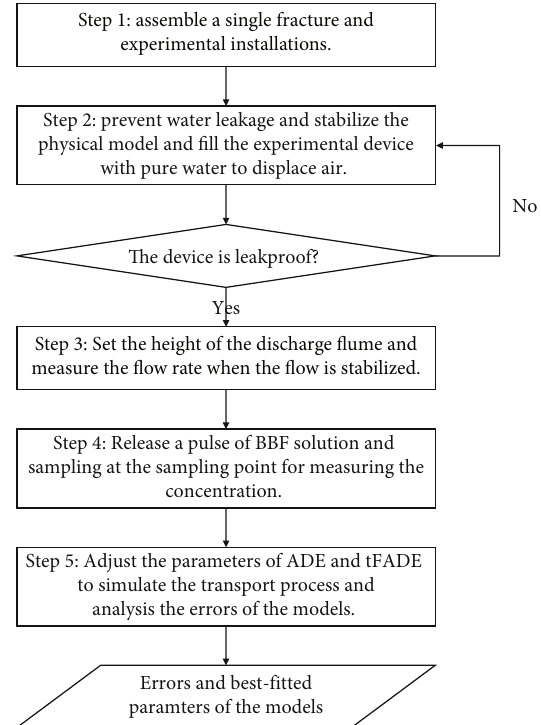
Figure 3: Flowchart for measuring errors and best- fi t parameters of ADE and